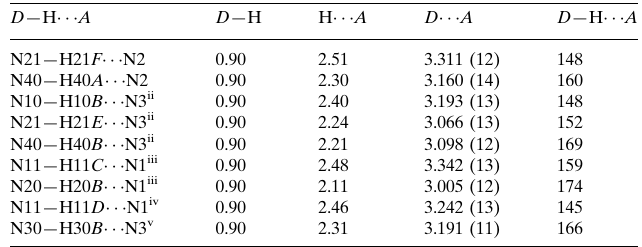
Hydrogen-bond geometry (A˚ , (cid:4)